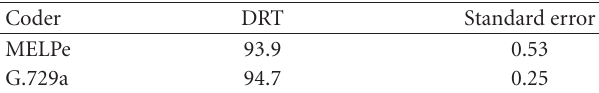
Table 1: DAM scores and standard error without environmental noise.